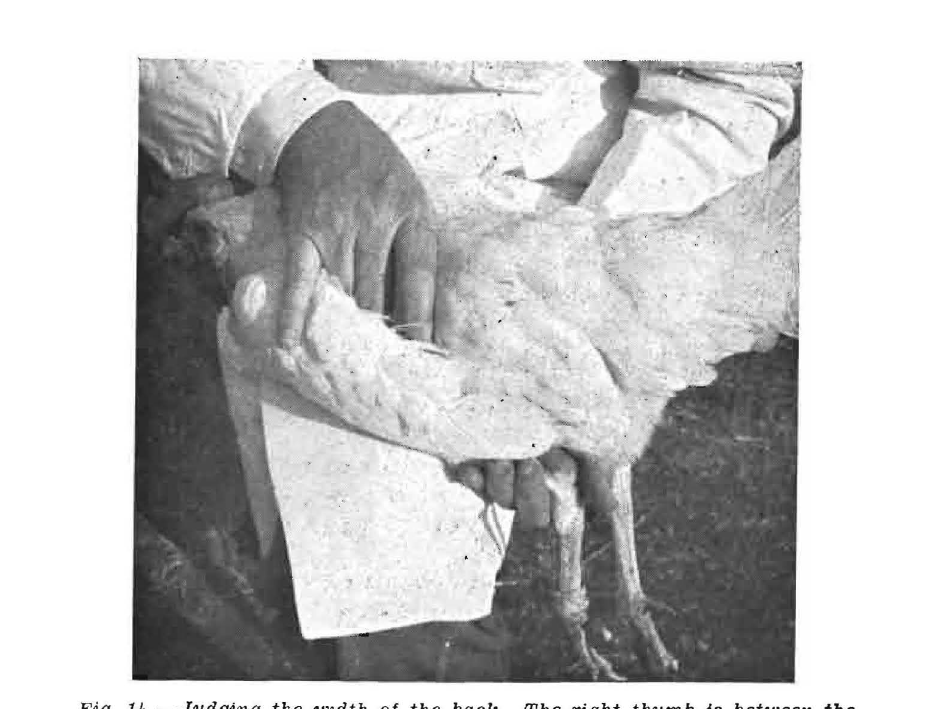
Fig. 14. -Judging the WIdth of the back. The right thumb is between the right wing and the hen's body. The right hand is slid back to the tail, to ascertain the width in different parts.